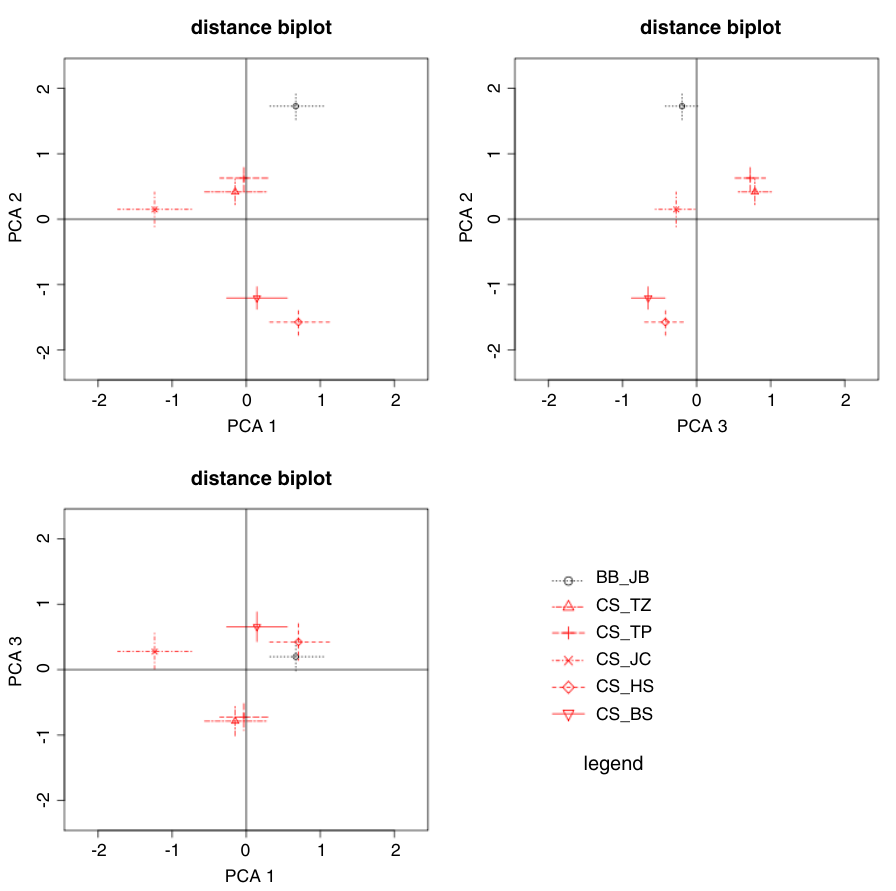
Figure 4. Updating principal component analysis of Canton S strains. Results from the PCA obtained using the same analysis as for Figure 2, but with data uploaded from different laboratories. The version of this figure on the F1000Research site is ‘living’; it will automatically re-plot as and when new data for other Canton S strains are submitted, and users can visualize previous versions of this figure. The conclusions of this article only relate to the data available at the time of publication. The prefixes in the key are the initials of the data contributor (except CS_ strains, which were tested by Julien Colomb); full names and affiliations can be found in the figure legend of the article on the F1000Research site. The suffixes denote the initials of the principal investigators from where each sub-strain was sourced. The BB_JB (Jose Botella) strain was ordered from the Bloomington stock center (stock #1) approx. seven years ago. BB_JB falls within the range of variability seen so far, but does not appear to clearly group with any of the previously measured strains. Instructions for adding data: Click the ‘Submit New Data’ button to the left of the figure on the online version of article and fill in the fields on the form (user registration may be required). ‘Uploader Name’ should be “First name, Last name”; ‘Uploader Lab Address’ should be “Department, University, Country”. For ‘Genotype’, use the initials of the principal investigator of the lab from where the strain originated (this will typically be the initials of the uploader). The data should be uploaded as one metadata and one data file for each fly (click links for template examples). Only one CS strain per lab should be uploaded. Please email BB for additional details on contributing data to this